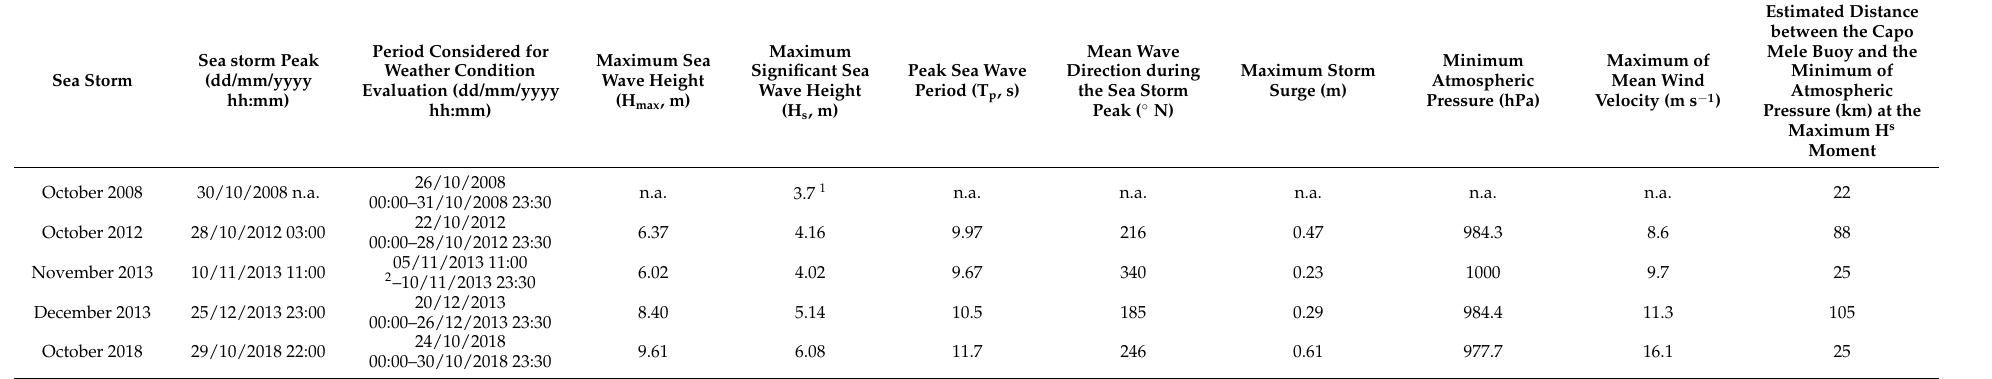
Table 1. Weather and sea data for the five sea storm events considered in this study. n.a.: not